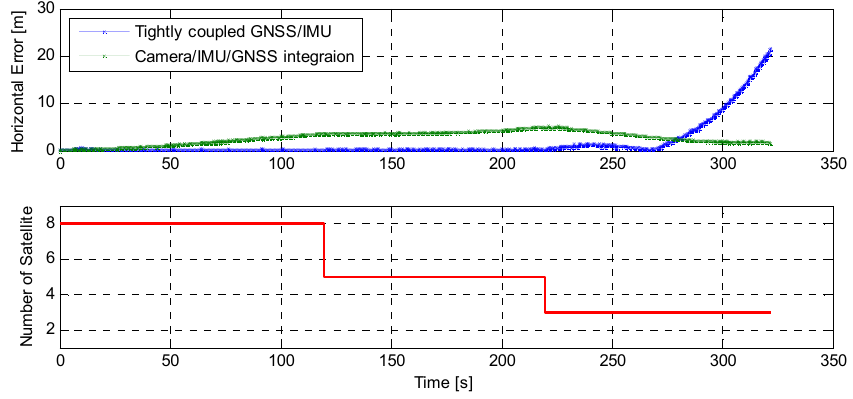
Figure 8. Comparison of horizontal error between the tightly coupled GNSS/IMU and camera/IMU/GNSS integrations in terms of reduced observability of GNSS measurements.